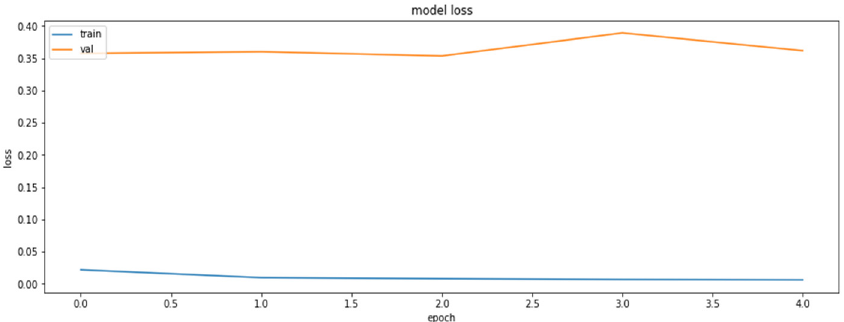
Figure A1. The loss function value for the training and the validation datasets obtained during the training of the model with the weights clustered with the KMeans++ initialization of 32 centroids.